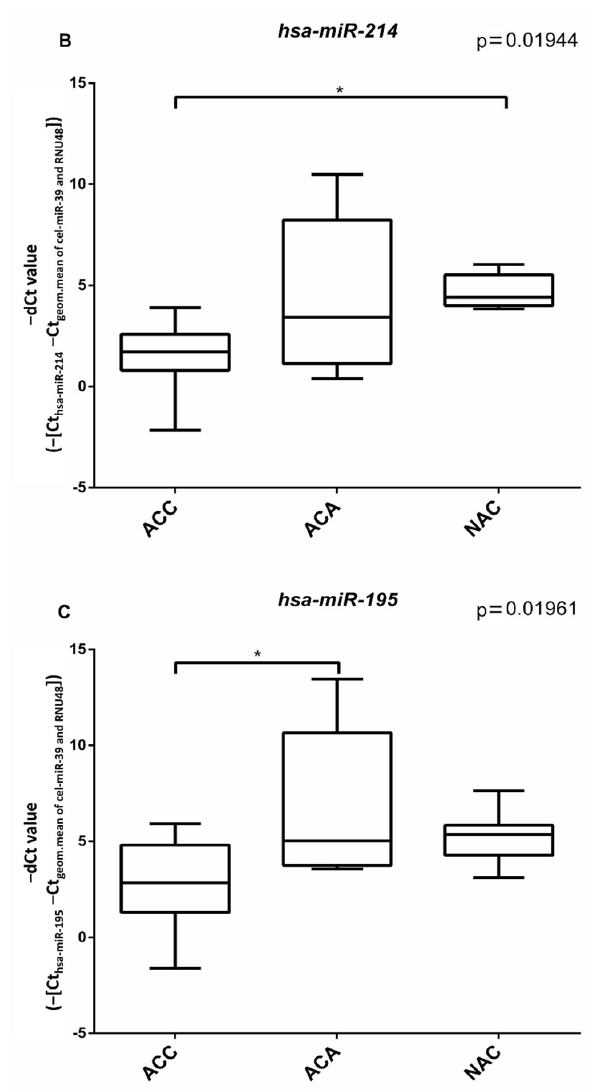
Figure 4. Box plots representing the expression of hsa-let-7c-3p ( A ), hsa-miR-214 ( B ) and hsa-miR-195 ( C ) miRNAs relative to the geometric means of cel-miR-39 Ct values and RNU48 Ct values in ACA, ACC and NAC samples. ANOVA and Tukey post-hoc tests (*: p < 0.05, **: p < 0.01) were